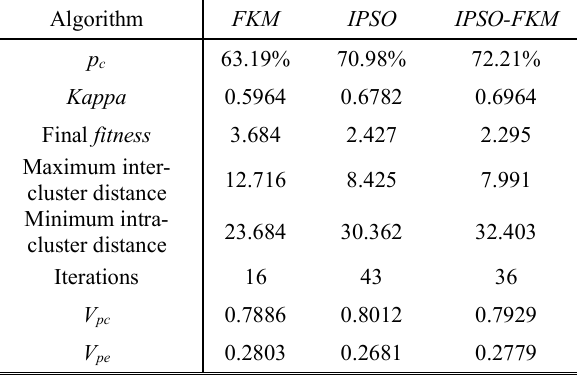
Table2. The comparison of the three